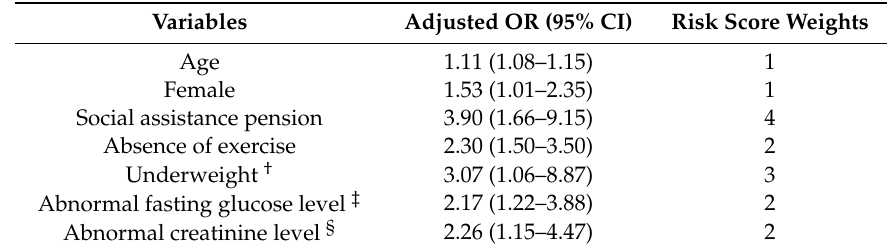
Table 3. Taiwan Risk Scores for Sarcopenia (TRSS) Model Estimated by Stepwise Logistic Regression.